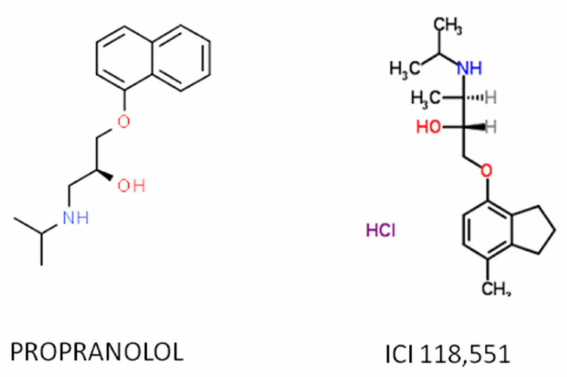
Figure 2. The atomic structure of the propranolol and ICI 118,551 molecules.